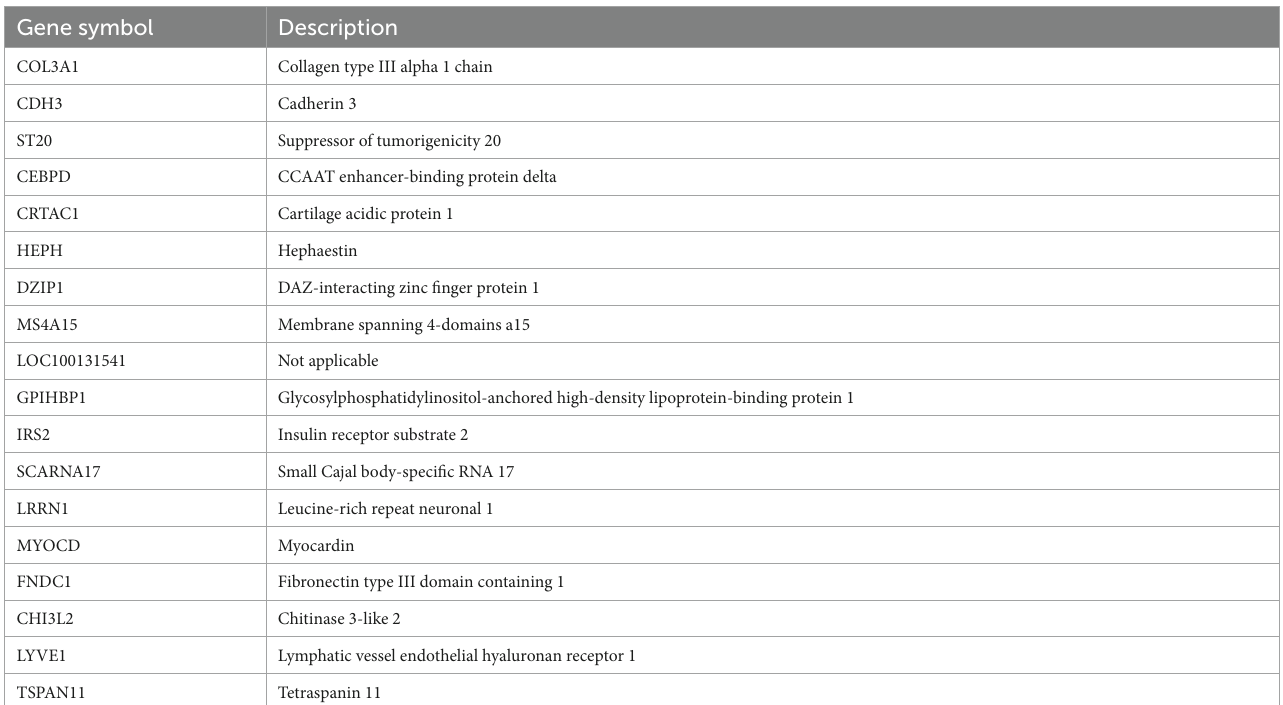
Figure 6B (regulatory T cells [Tregs] were not correlated with any other cell and are hence not shown).